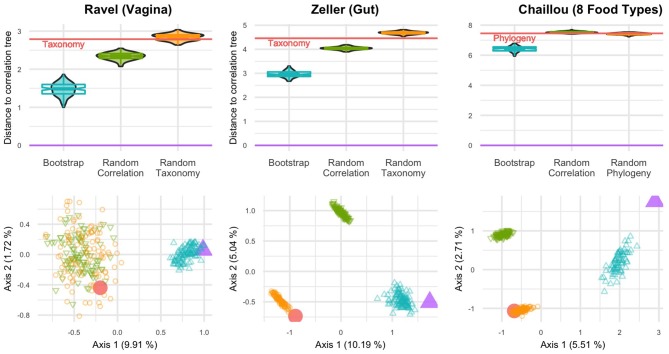
BHV distances between various trees for three datasets: Ravel (left), Zeller (center) and Chaillou (right). (Top) Violinplots and notched boxplots of distances to the correlation tree. The distance between taxonomy (or phylogeny) and correlation is indicated by the red line. (Bottom) PCoA projection of all distances on the principal plane. The correlation tree is in purple (△), taxonomy (or phylogeny) in red (○), bootstrapped trees in blue, random correlation trees and random taxonomies (or phylogenies) in green and orange respectively.